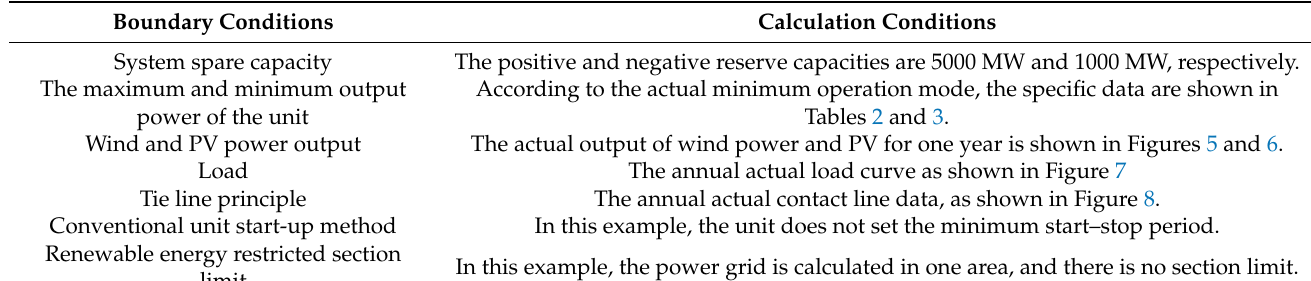
Table 1. The boundary conditions for renewable energy accommodation capacity